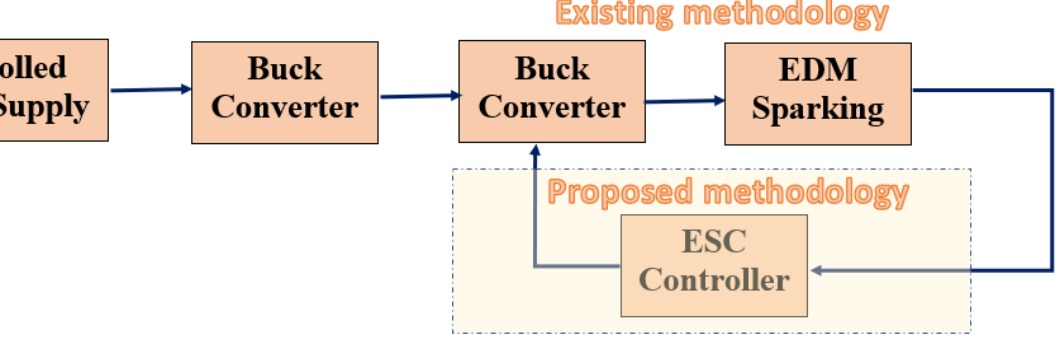
Figure 2. Proposed low-power EDM with ESC controller in feedback path.